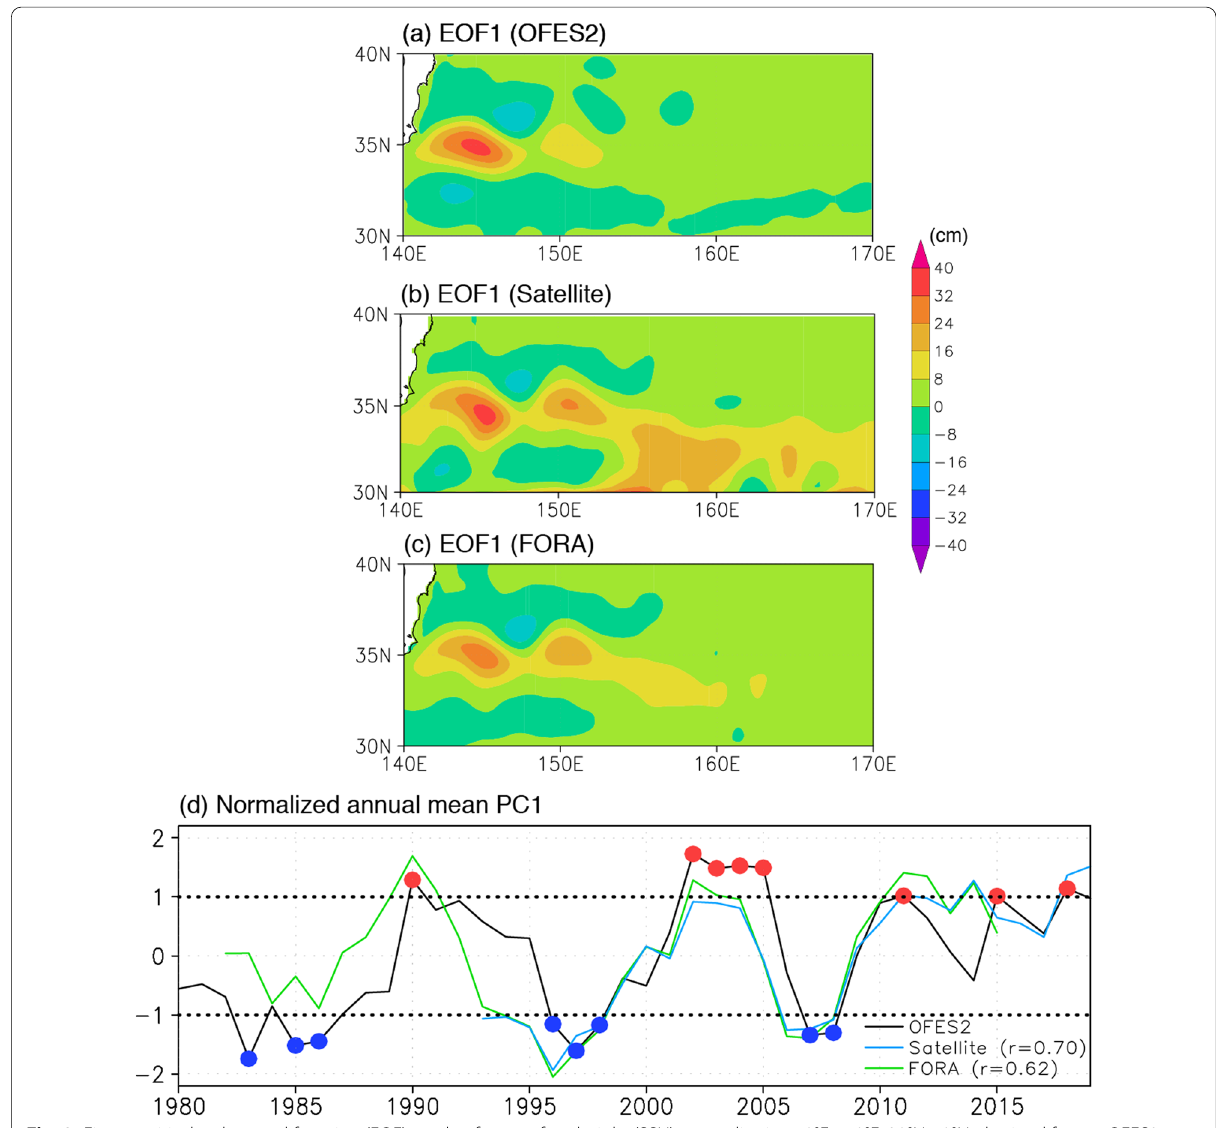
Fig. 3 First empirical orthogonal function (EOF) mode of sea surface height (SSH) anomalies in 140°E-170°E, 30°N-40°N obtained from a OFES2, b satellite observation, and c FORA. d Normalized annual mean of the first principal component (PC) of SSH anomalies in 140°E-170°E, 30°N-40°N obtained from the OFES2 (black line), satellite observation (light blue line), and FORA (green line). The horizontal black dotted lines represent standard deviation, and the red (blue) dots represent the stable (unstable)